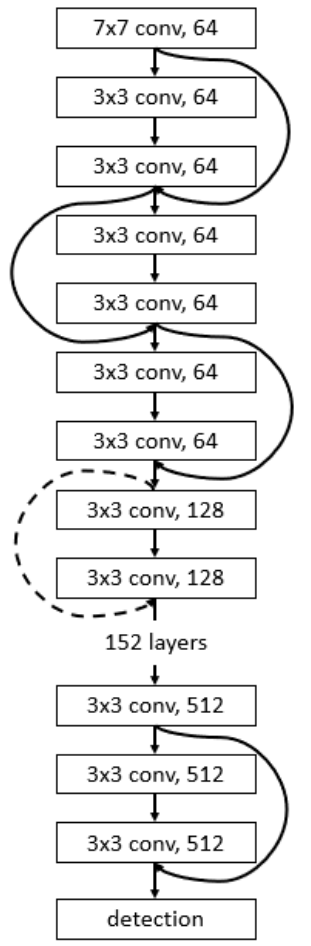
Figure 1. Architecture diagram of the ResNet-152 convolutional neural network (CNN) used.